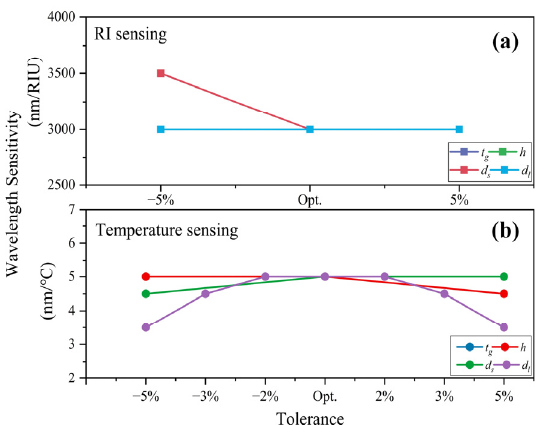
Figure 13. Wavelength sensitivity of ( a ) RI sensing for structure parameter t g , h , d s , and d l with ±5% tolerance, and ( b ) temperature sensing for structure parameter t g , h , d s with ±5% tolerance, and d l with ±2%, ±3%, ±5% tolerance.